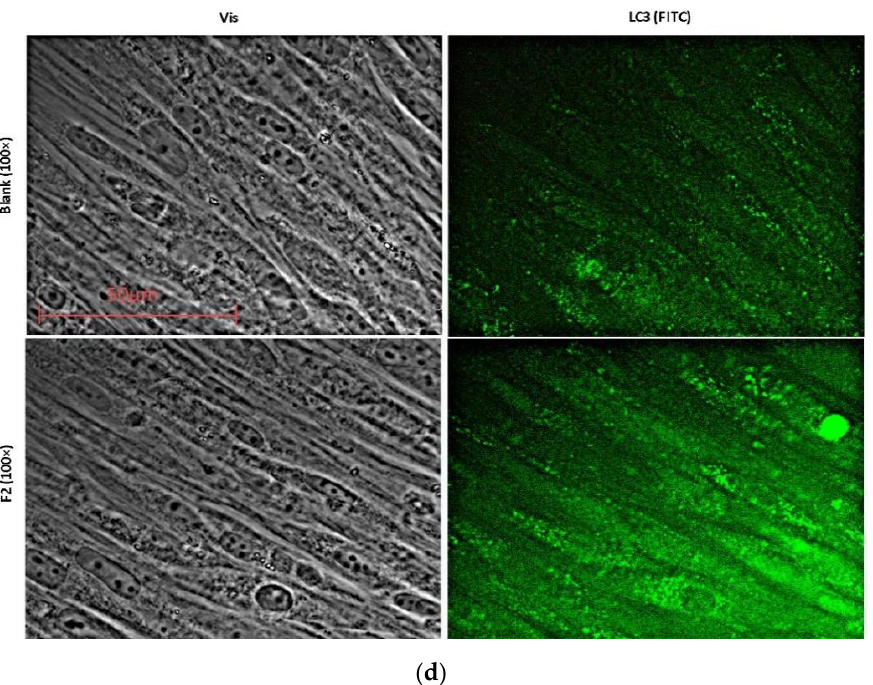
Figure 13. The effect of F1, F2, and F3 on the autophagy genes ( a ) and proteins ( b ); the concentrations of fullerenes are shown in the figure. The gene RNA amount was the mean value for three experiments related to the blank; the TBP gene was used as an internal reference gene; FL1 values were calculated for three experiments related to the blank; (*) denotes significant differences compared to blank cells, p < 0.005, in a Mann –Whitney test. Distribution of MSCs treated with F2 (195 μM, 14 days) according to the intensity of the antibody signal ( c ). Expression of LC3 (staining with fluorescein isothiocyanate (FITC)) 14 days after incubation of MSCs with F2 (195 μM) ( d ); fluorescence microscopy, 40×. In blank experiments, cells were incubated without the fullerenes.